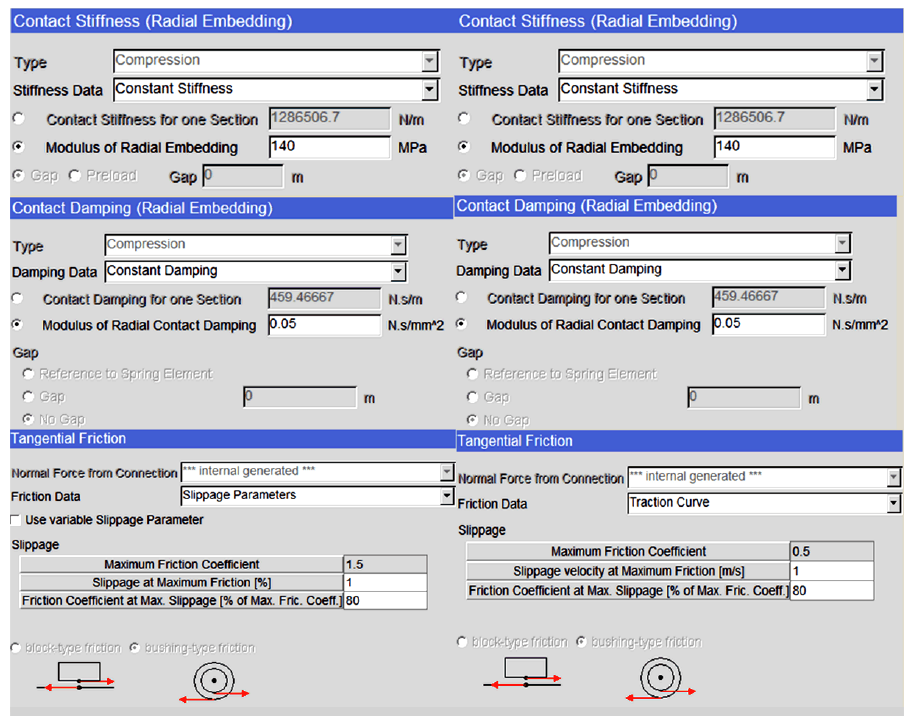
Figure 10. FEAD multi-body model parameters including global data, drive layout, rotational elements’ properties, belt geometry, and its mass and elasticity properties [10].